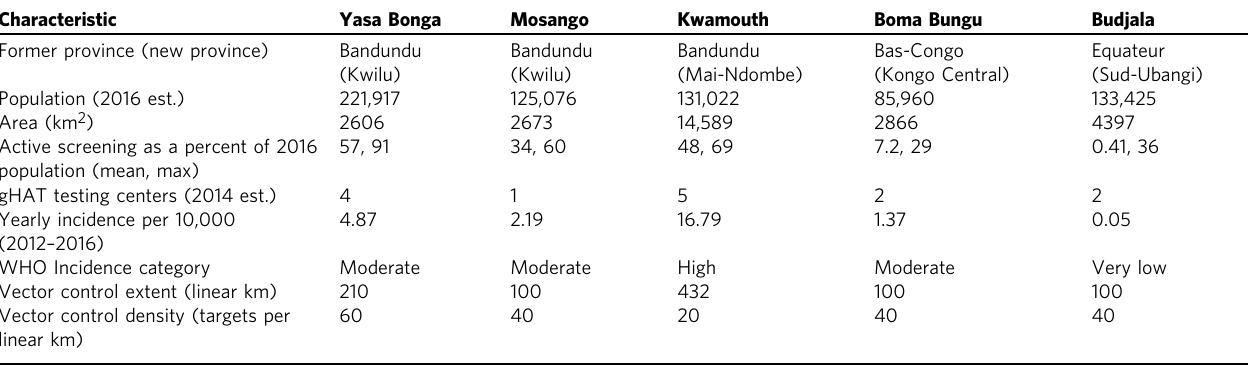
Table 1 Descriptive summaries of fi ve health zones.